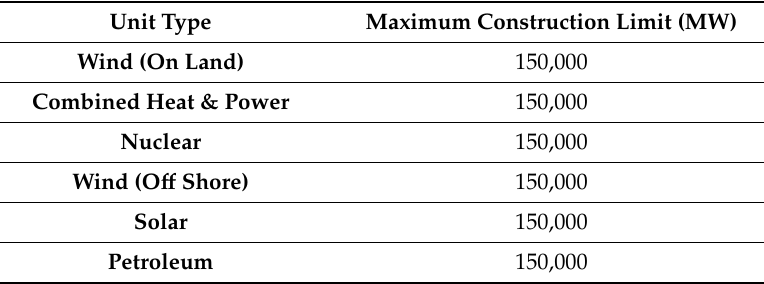
Table A15. Overall Construction Limits by